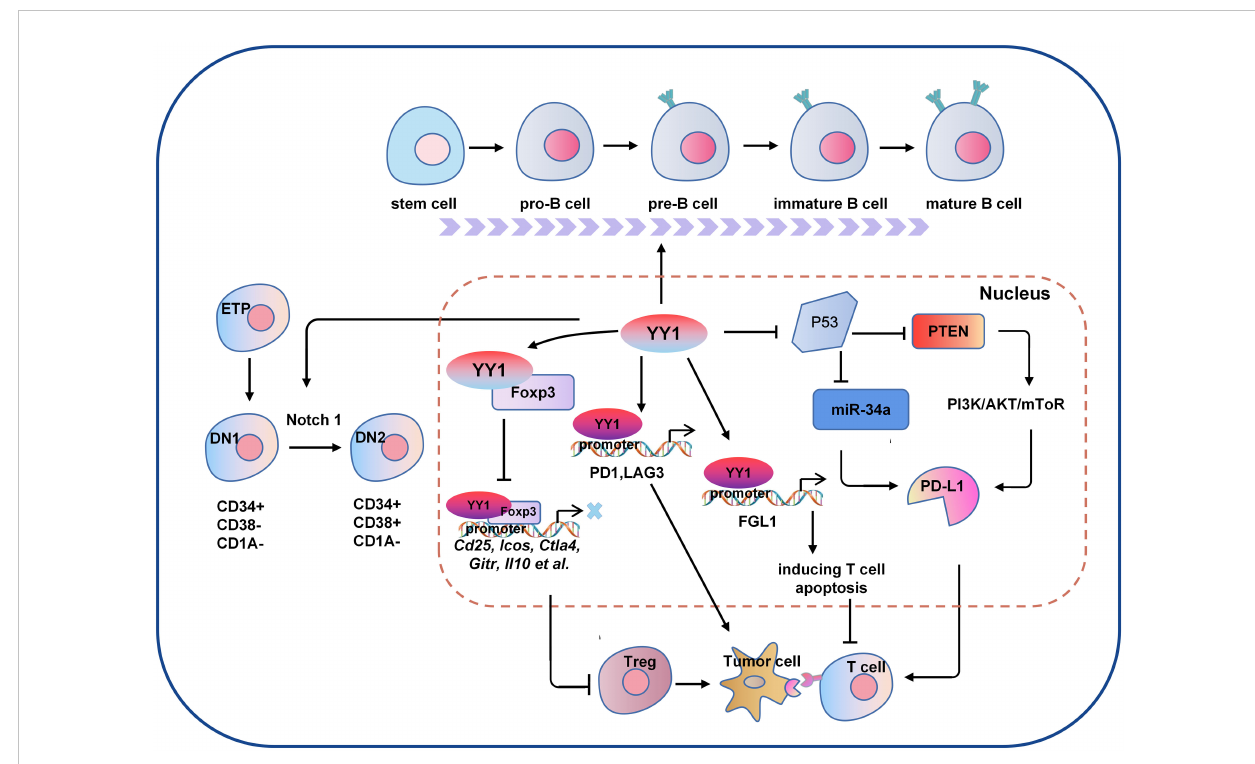
FIGURE 2 The molecular mechanism of YY1 regulating B cell and T cell-mediated tumor immunity. Several signaling pathways crosstalk exist between the regulations of YY1 and T cell function. For example, YY1 inhibits the function of T cells by blocking Foxp3 mediated transcription of its downstream genes Cd25, Icos, Ctla4, Gitr and Il10 et al., or directly regulating the expression of PD1 and LAG3 by binding to their promoter regions. In addition, YY1 promotes the DN1-to-DN2 T cell transition by activating Notch1 pathway. For B cells, YY1 is essential for all stages of B cell differentiation, thus to be involved in B cells-mediated immune escape. DN1, double negative 1; DN2, double negative 2; PD-L1: programmed death ligand 1; Foxp3, forkhead box